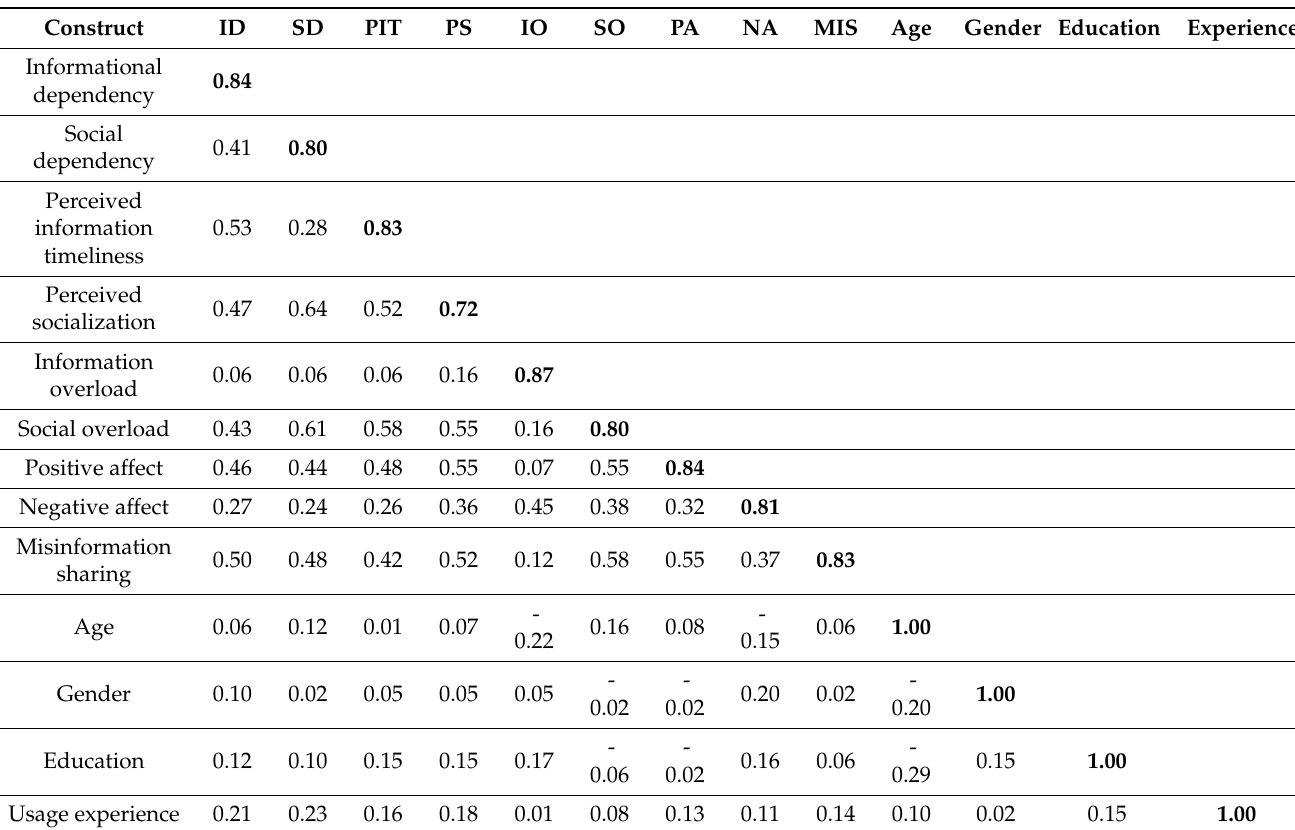
Table 3. Correlation